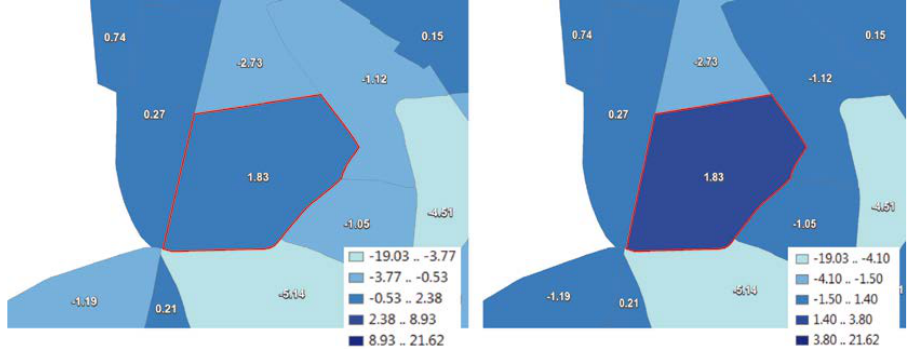
Figure 4. Depending on the data classification method, local extreme values (outlined in red) can be partially categorized with neighboring regions into one class ( left ; using the natural breaks method, the extreme value polygon is in the same class (0.53 .. 2.38) as its left neighbor), or be isolated in one class as desired ( right , using the proposed method); data set B (see Table 4).